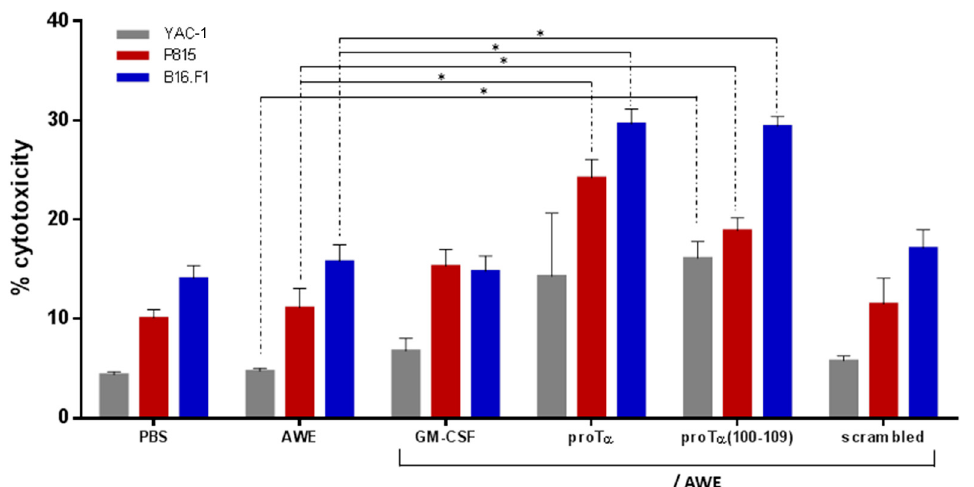
Figure 4. Combined administration of proT α or proT α (100–109) with AWE promoted T- and NK effector cell cytotoxicity in vivo. Cytotoxicity was measured by standard 51 Cr-release assay. Total spleen cells from treated mice were used as effectors (E) against target (T) YAC-1, P815, and B16.F1 cells at an E:T ratio of 100:1. Mean % cytotoxicity ± SD from five mice/group is shown. * p < 0.05 compared to AWE.